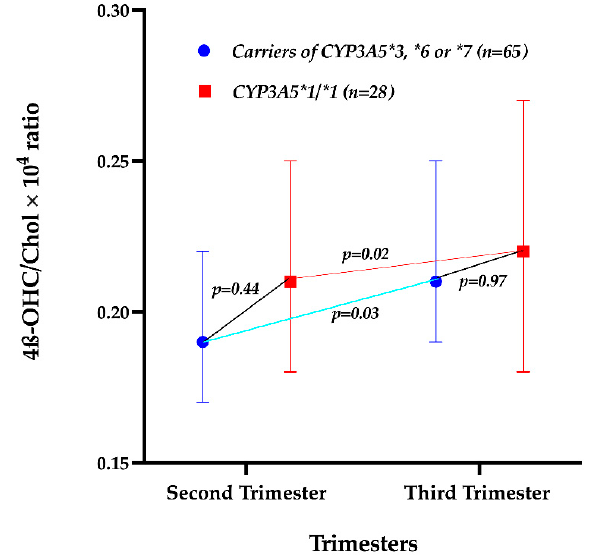
Figure 2. Comparison of the geometric mean of the 4 β -OHC/Chol × 10 4 ratio between CYP3A5 genotypes among pregnant women in the second and third trimesters. The red squares indicate the geometric mean of the 4 β -OHC/Chol × 10 4 ratio in women with CYP3A5*1/*1 genotypes, while the blue dots indicate the geometric mean of the 4 β -OHC/Chol × 10 4 ratio in carriers of defective CYP3A5*3*6*7 alleles in the second and third trimesters. The whiskers indicate the 95% confidence interval of the means.